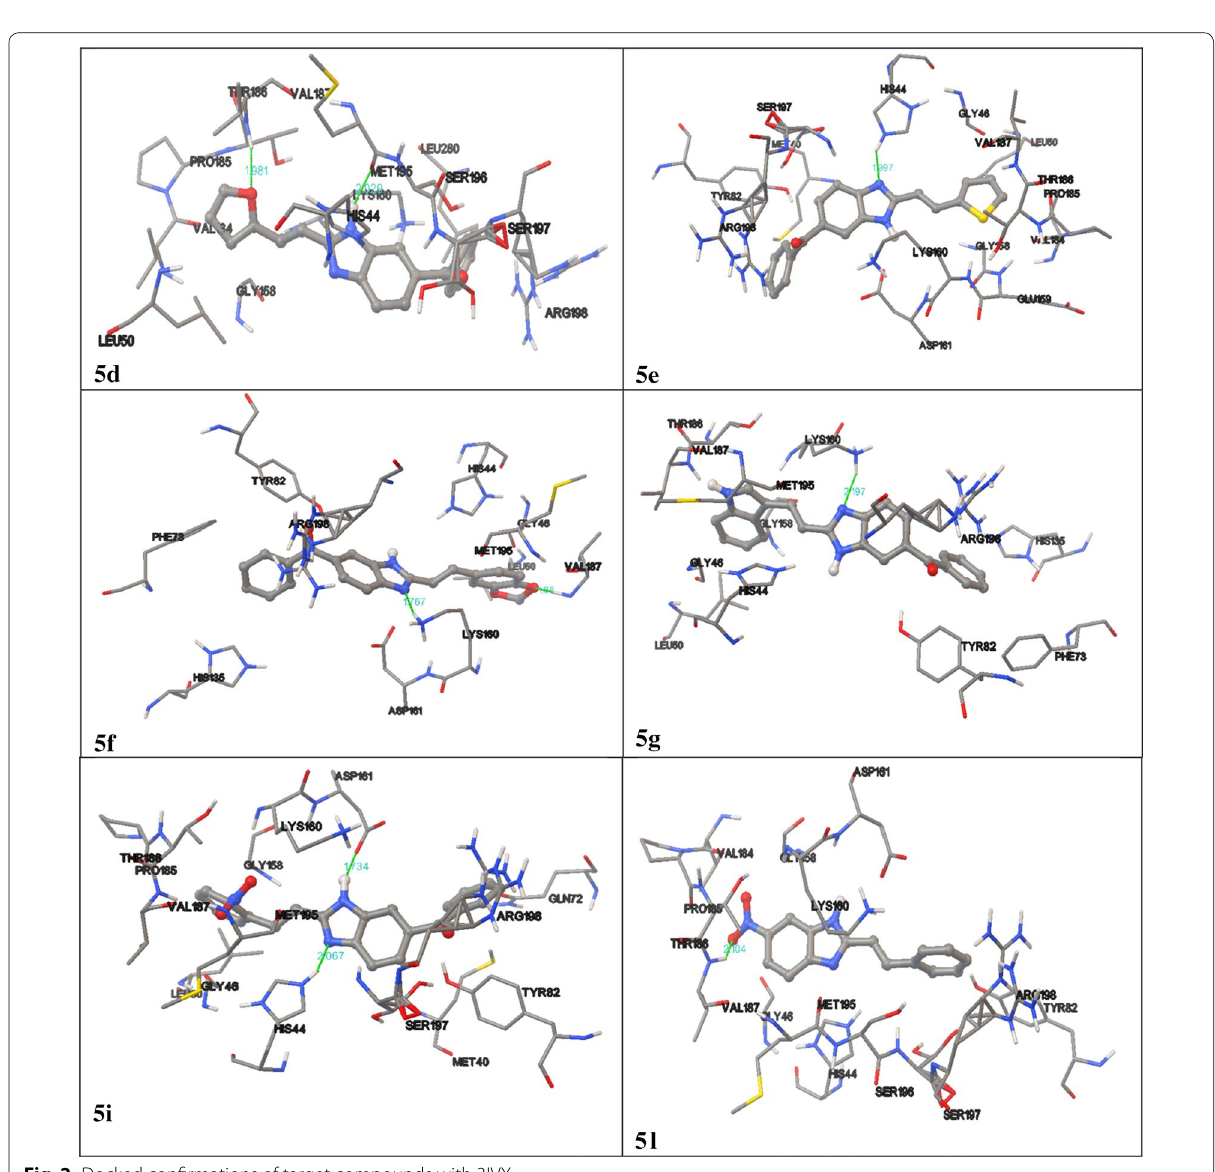
Fig. 2 Docked confirmations of target compounds with 3IVX